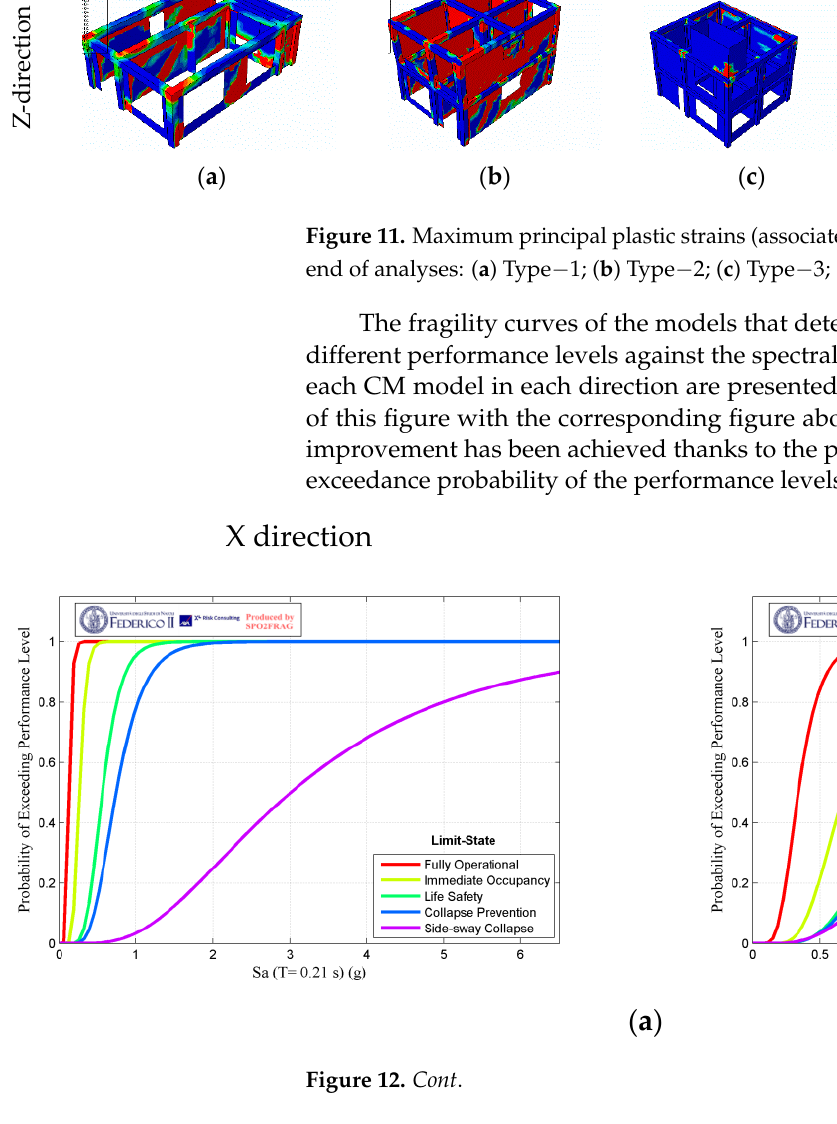
( b ) ( c ) ( d ) Figure 12. Push-over-based fragility curves of the CM models: ( a ) Type-1; ( b ) Type-2; ( c ) Type-3; ( d ) Type-4.